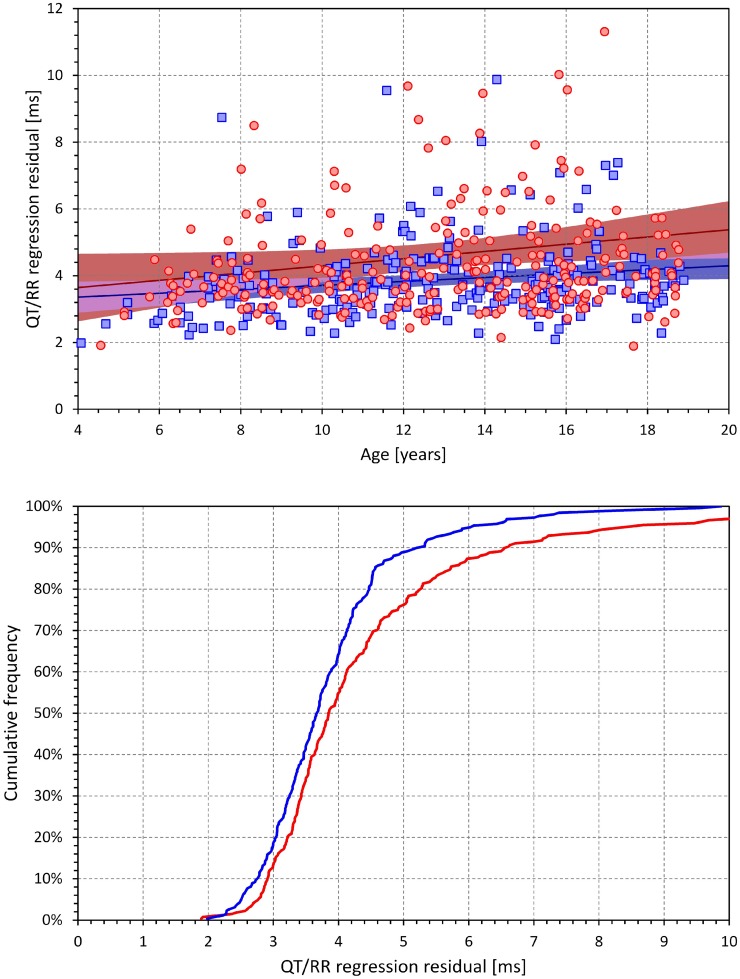
The (top) panel show the age dependency of the curvilinear QT/RR regression residuals. The red circles and blue squares correspond to the female and male subjects, respectively. The dark red and dark blue lines are linear regressions in females and males, respectively; the light red and light blue areas are the 95% confidence bands of the sex-specific linear regression lines. The violet areas are the overlaps between the confidence bands of the regression lines of both sexes. The (bottom) panel shows the cumulative distributions of QT/RR regression residuals in female (bold red line) and male (bold blue line) subjects.